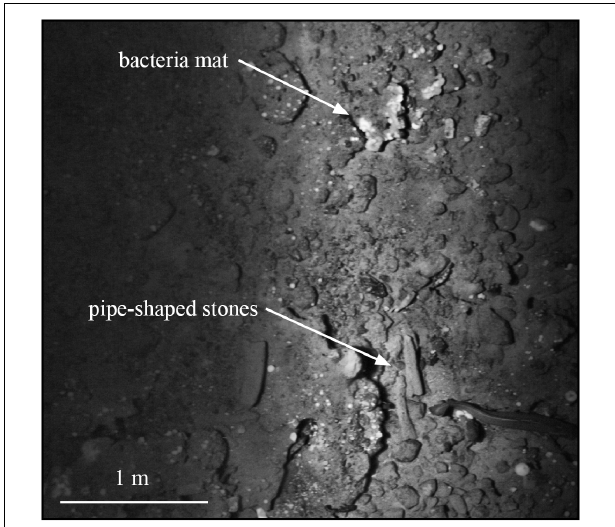
FIGURE 7 | TFish photo showing bacteria mats and pipe-shaped stones likely representing past fluid flow conduits.